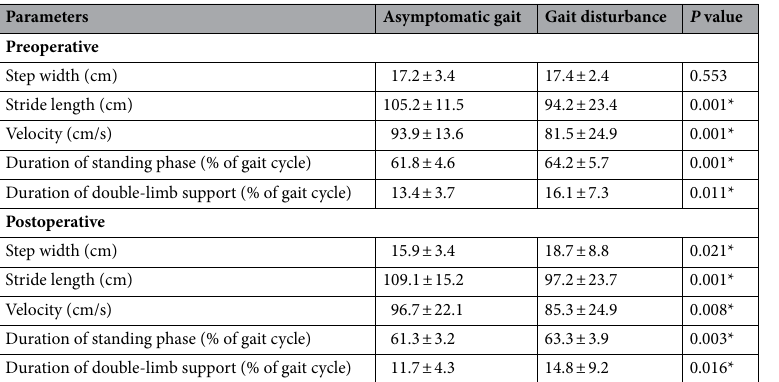
Table 2. Comparison of temporospatial parameters between asymptomatic gait and gait disturbance groups. * P < 0.05.